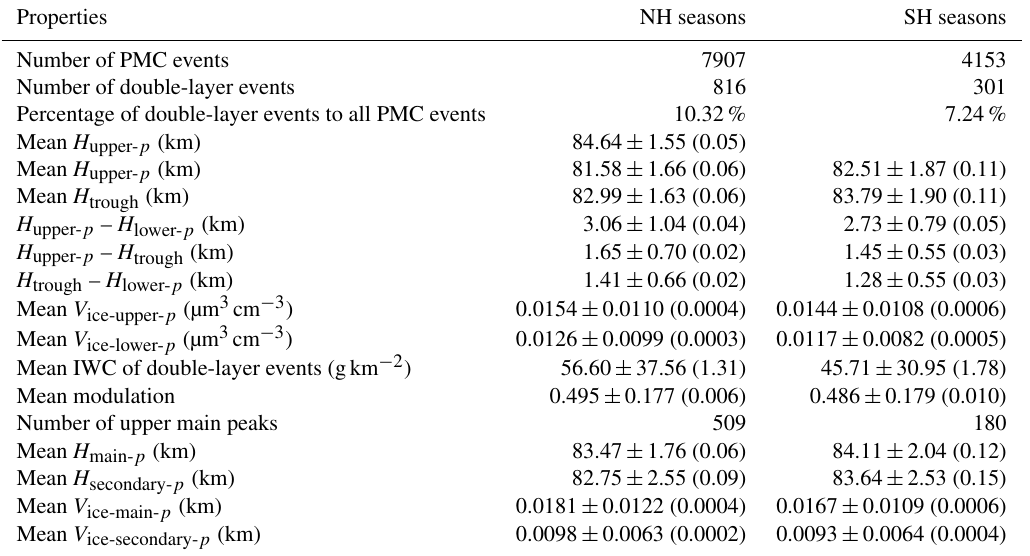
Table 1. Properties of PMCs with double-layer structure. The mean value, the standard deviation and the standard deviation of the mean (in brackets) are